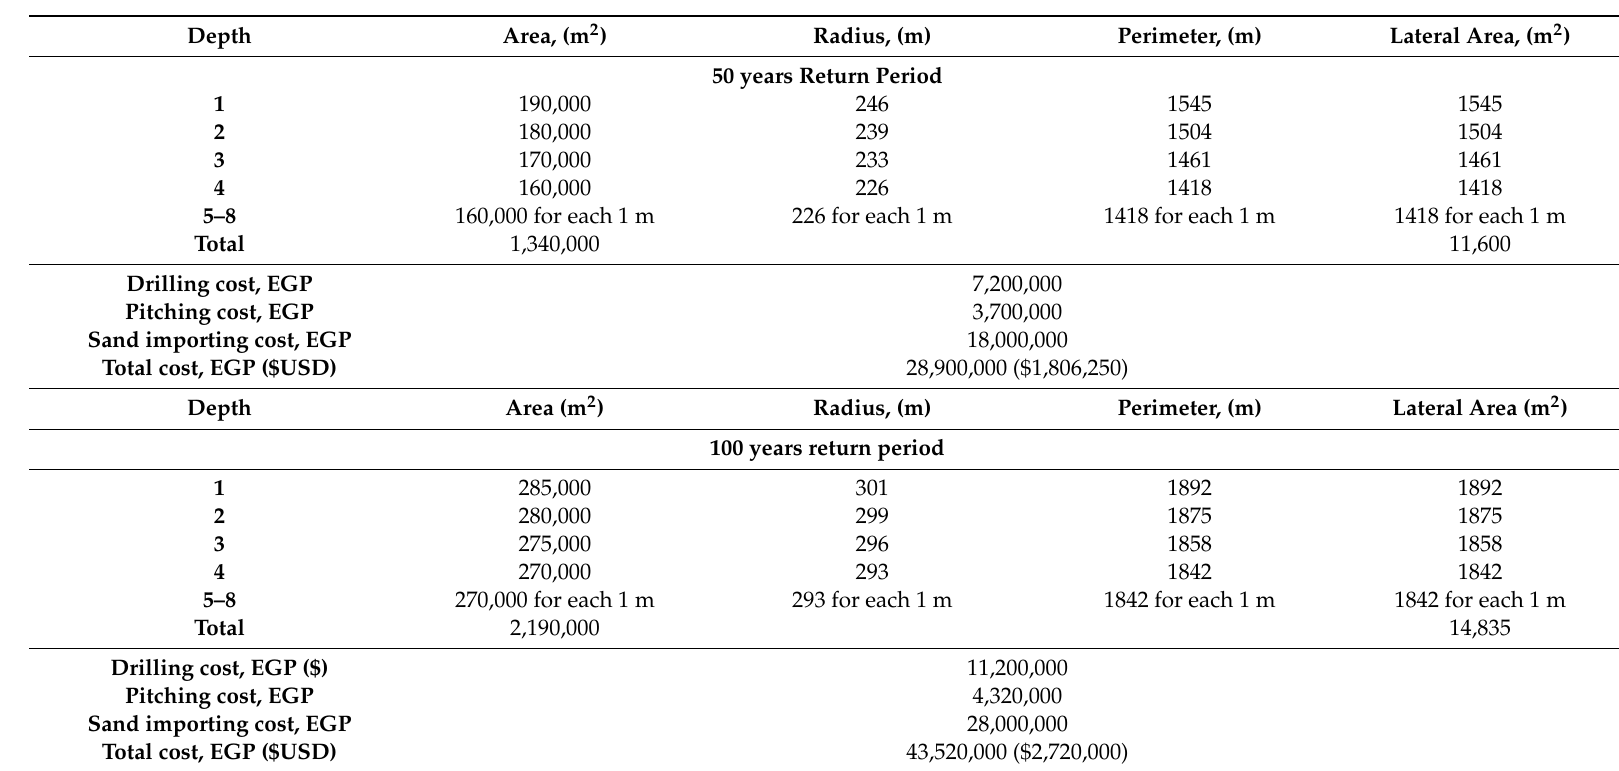
Table 7. Total cost estimation for each process for the 50- and 100-years return